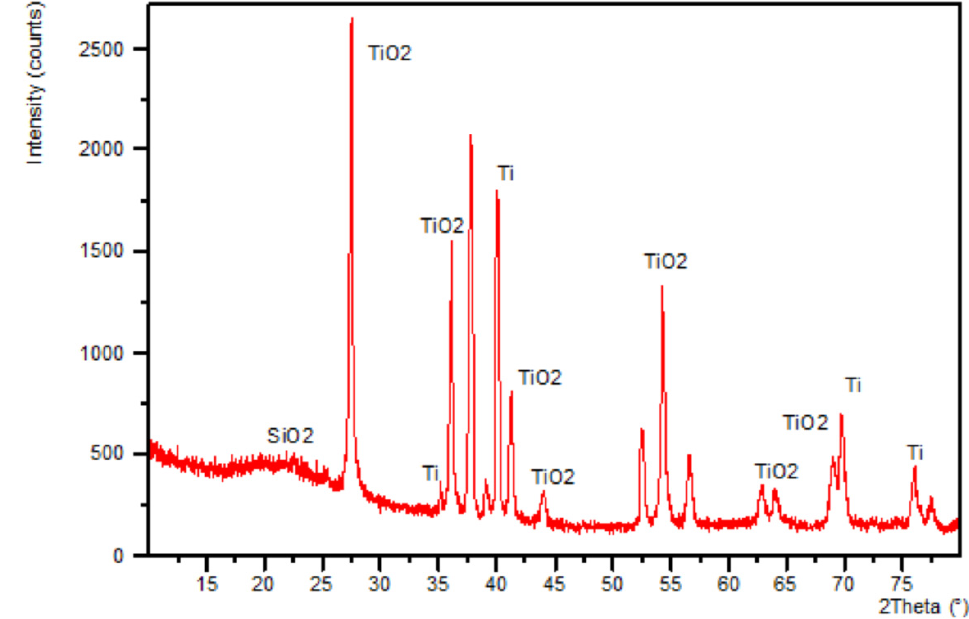
Figure 6. XRD diffraction pattern of the thin film deposited from Aerosil TM solution on the titanium alloy as the substrate.